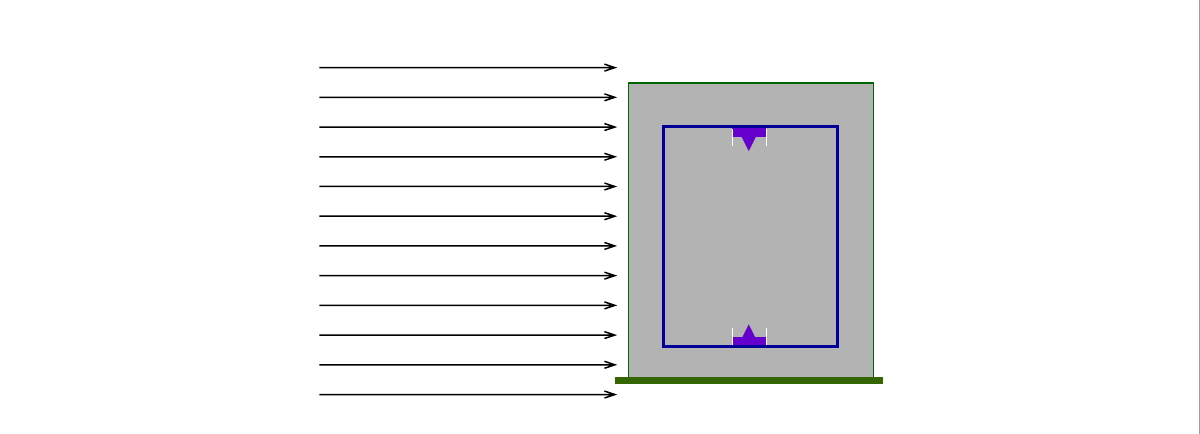
FIGURE 3 An illustration of the simulation geometry for the detector dose response simulations in MCNP 6.2. The cylindrical detector is con fi ned in an aluminium container and exposed to monoenergetic beams.